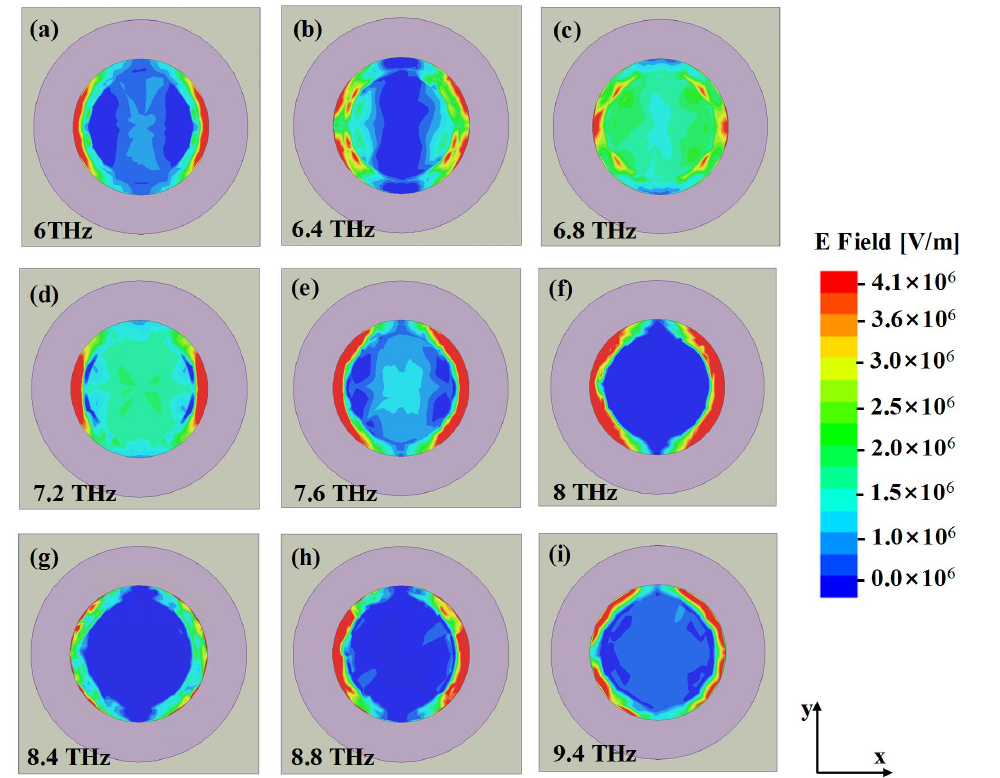
Figure 6. Typical distributions of the electric field at the distance 50 nm above the interface between the upper graphene and the silicon cylinder at ( a ) 6 THz, ( b ) 6.4 THz, ( c ) 6.8 THz, ( d ) 7.2 THz, ( e ) 7.6 THz, ( f ) 8 THz, ( g ) 8.4 THz, ( h ) 8.8 THz, ( i ) 9.4